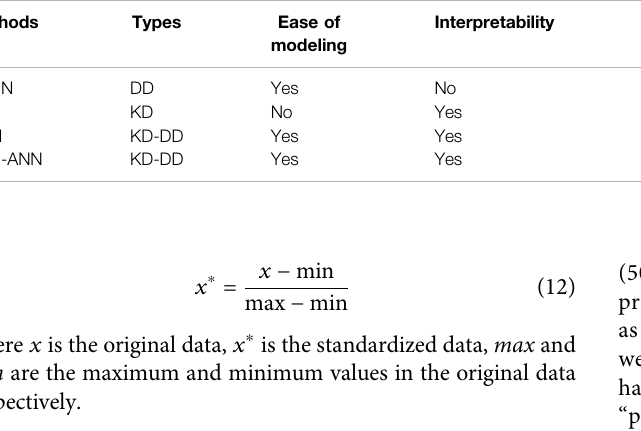
TABLE 10 | The comparative results of the four methods. Methods